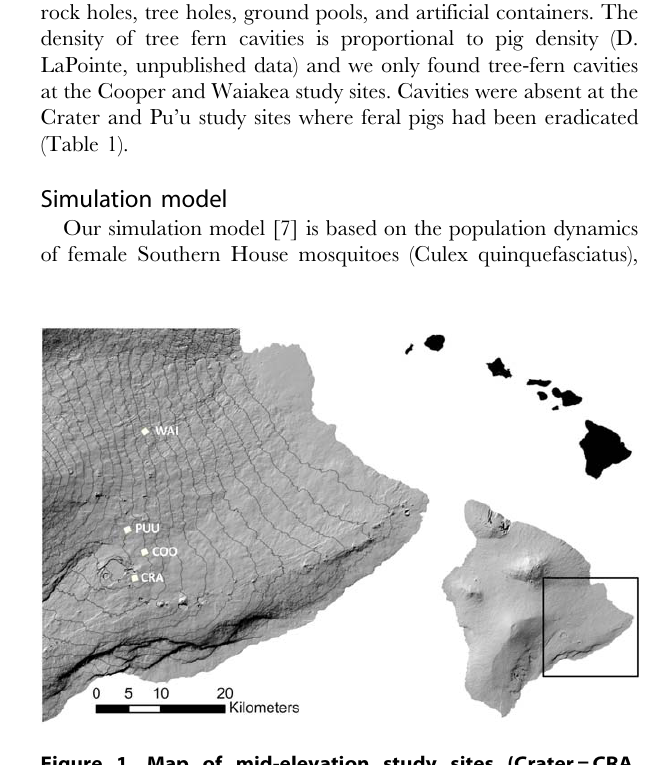
Figure 1. Map of mid-elevation study sites (Crater=CRA, Cooper=COO, Pu’u=PUU, Waiakea=WAI) located on the eastern slope of Mauna Loa and Kilauea Volcanoes on the Island of Hawaii. Elevation contours are 100 meter intervals. See text for additional information on study sites.